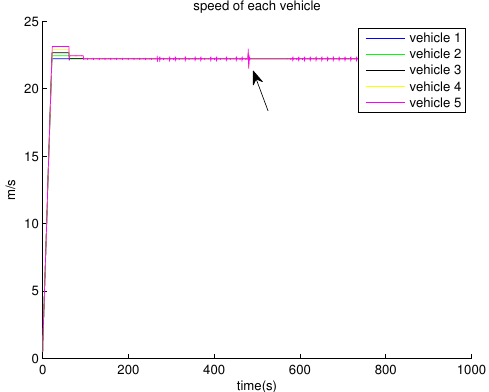
Figure 8. The speed of every heterogeneous truck converges to the speed of the leader as time goes on. γ = 1.01 is used. No Gaussian noise is used. See that the deviation of every truck’s speed decreased, compared to the case where Gaussian noise is used. A truck speed overshoot (marked with arrow) happens at the moment when the truck changes its lane. See Figure 3 for the moment when the truck changes its